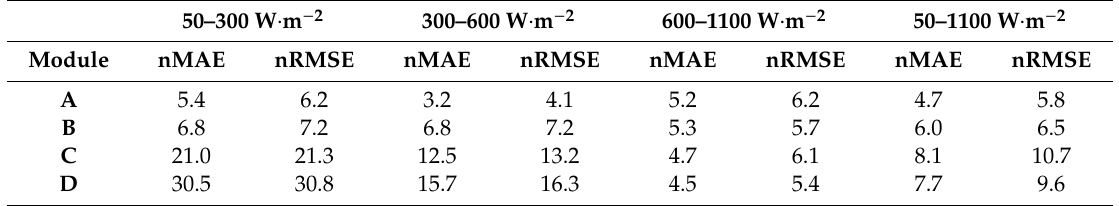
Table 6. Normalized nMAE and nRMSE on computed T c via [35], per irradiance range, in %.